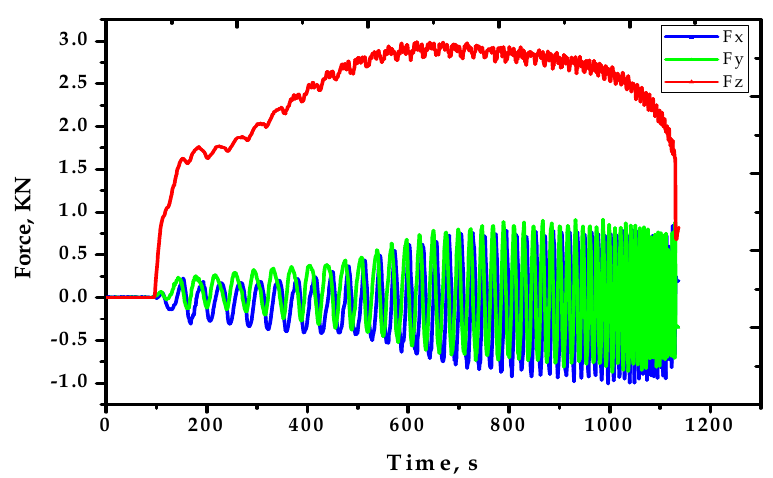
Figure 16. Forming forces in the three directions for the cone produced with run 7. Metals 2017 , 7 , 484